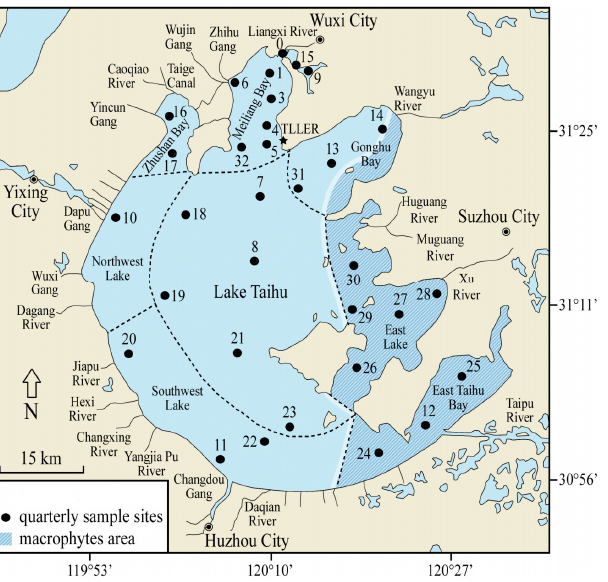
Figure 1. The locations of sampling sites in Lake Taihu. The figure is cited and adapted from Xu et al., 2014